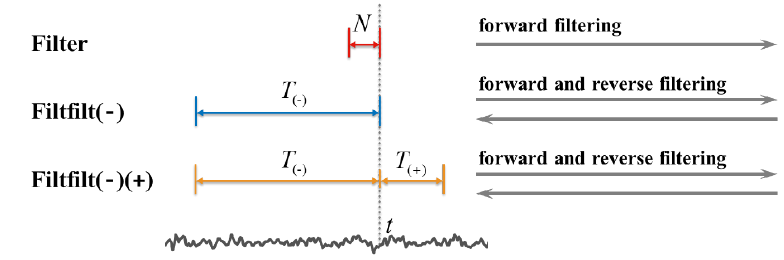
Figure 6. The schematic of the three filtering strategies tested in this study.